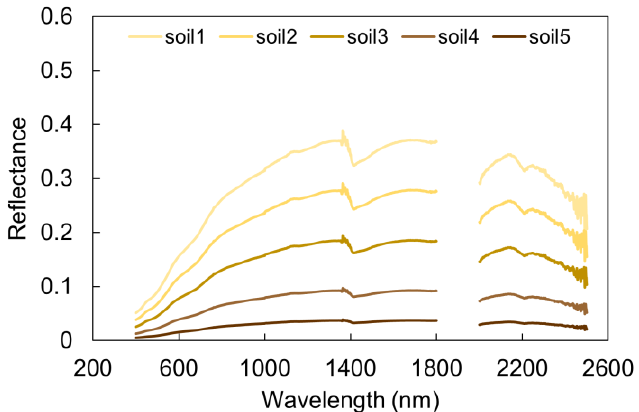
Figure 2. Soil reflectance used in the 4SAIL model. Soil1 reflectance is obtained from the field measurement. The others are the soil1 spectrum multiplied by different brightness coefficients.